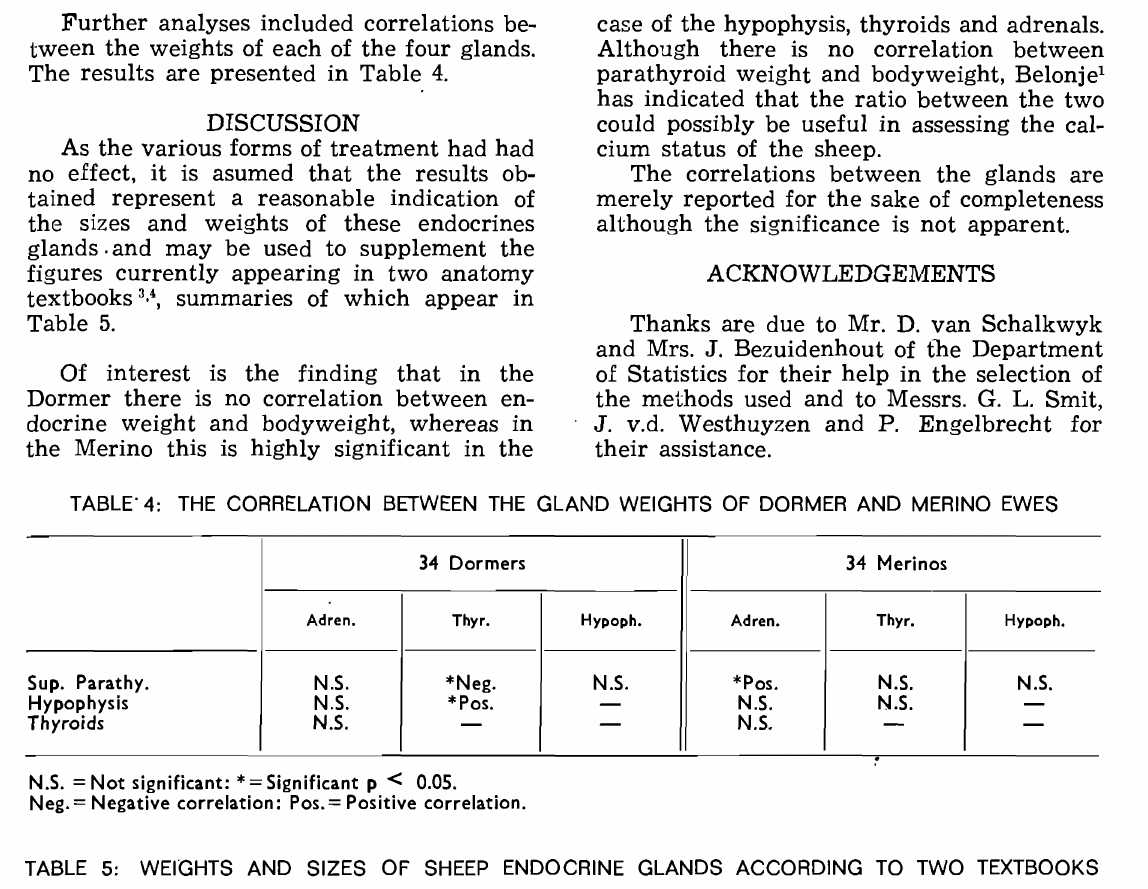
TABLE 5: WEIGHTS AND SIZES OF SHEEP ENDOCRINE GLANDS ACCORDING TO TWO TEXTBOOKS